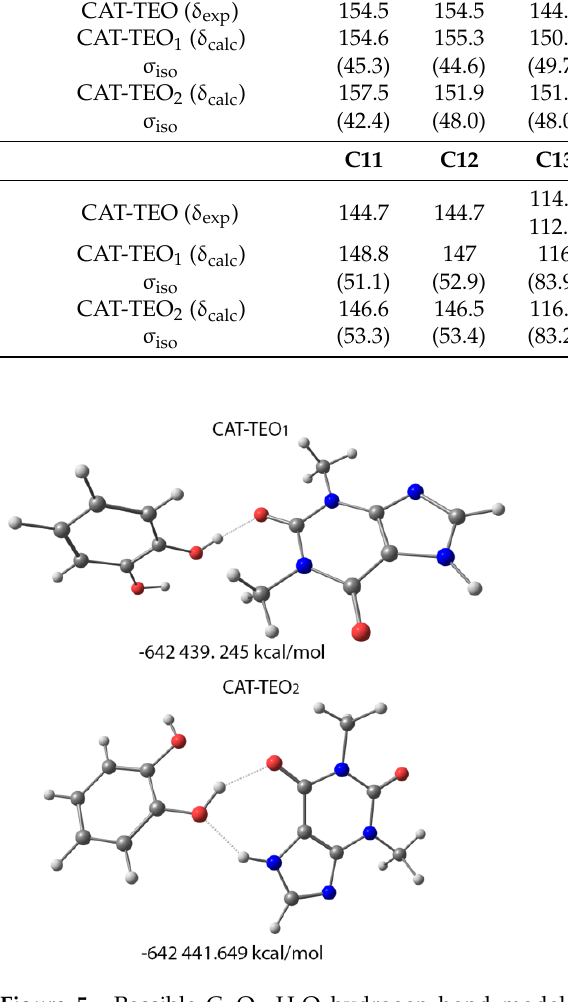
Figure 5. Possible C=O···H-O hydrogen bond models and optimized structures of the CAT-TEO cocrystal.